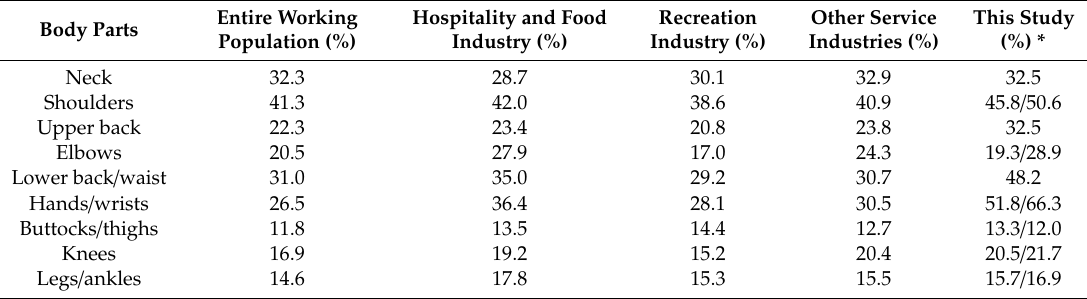
Table 1. Prevalence of musculoskeletal discomfort in various body parts between bakery workers and workers in other industries.